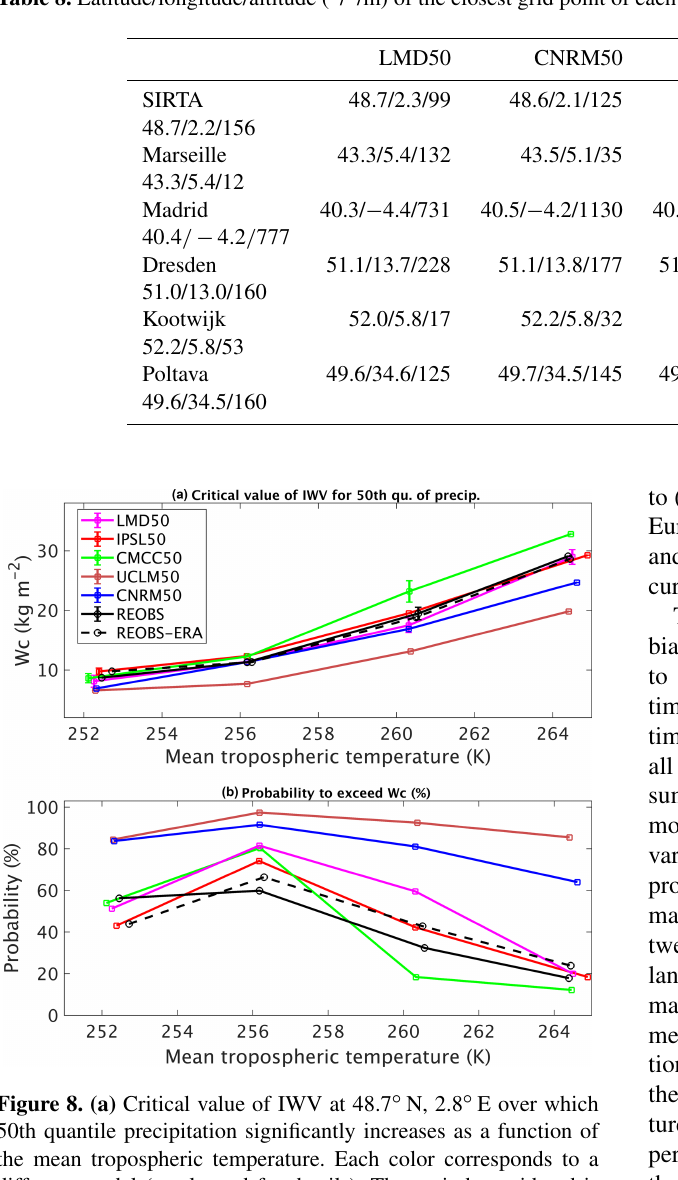
Table 8. Latitude/longitude/altitude ( ◦ / ◦ /m) of the closest grid point of each model for the GPS stations used.